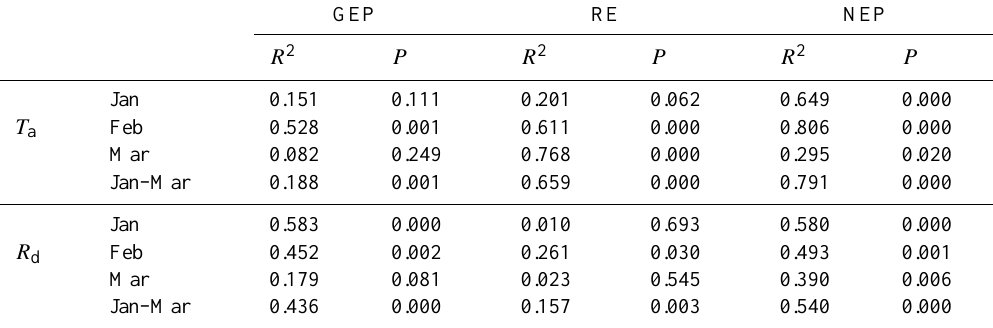
Table 3. The relationships between the CO 2 fluxes and T a /solar radiation at 10-day scale during 2003–2008. GEP RE NEP R 2